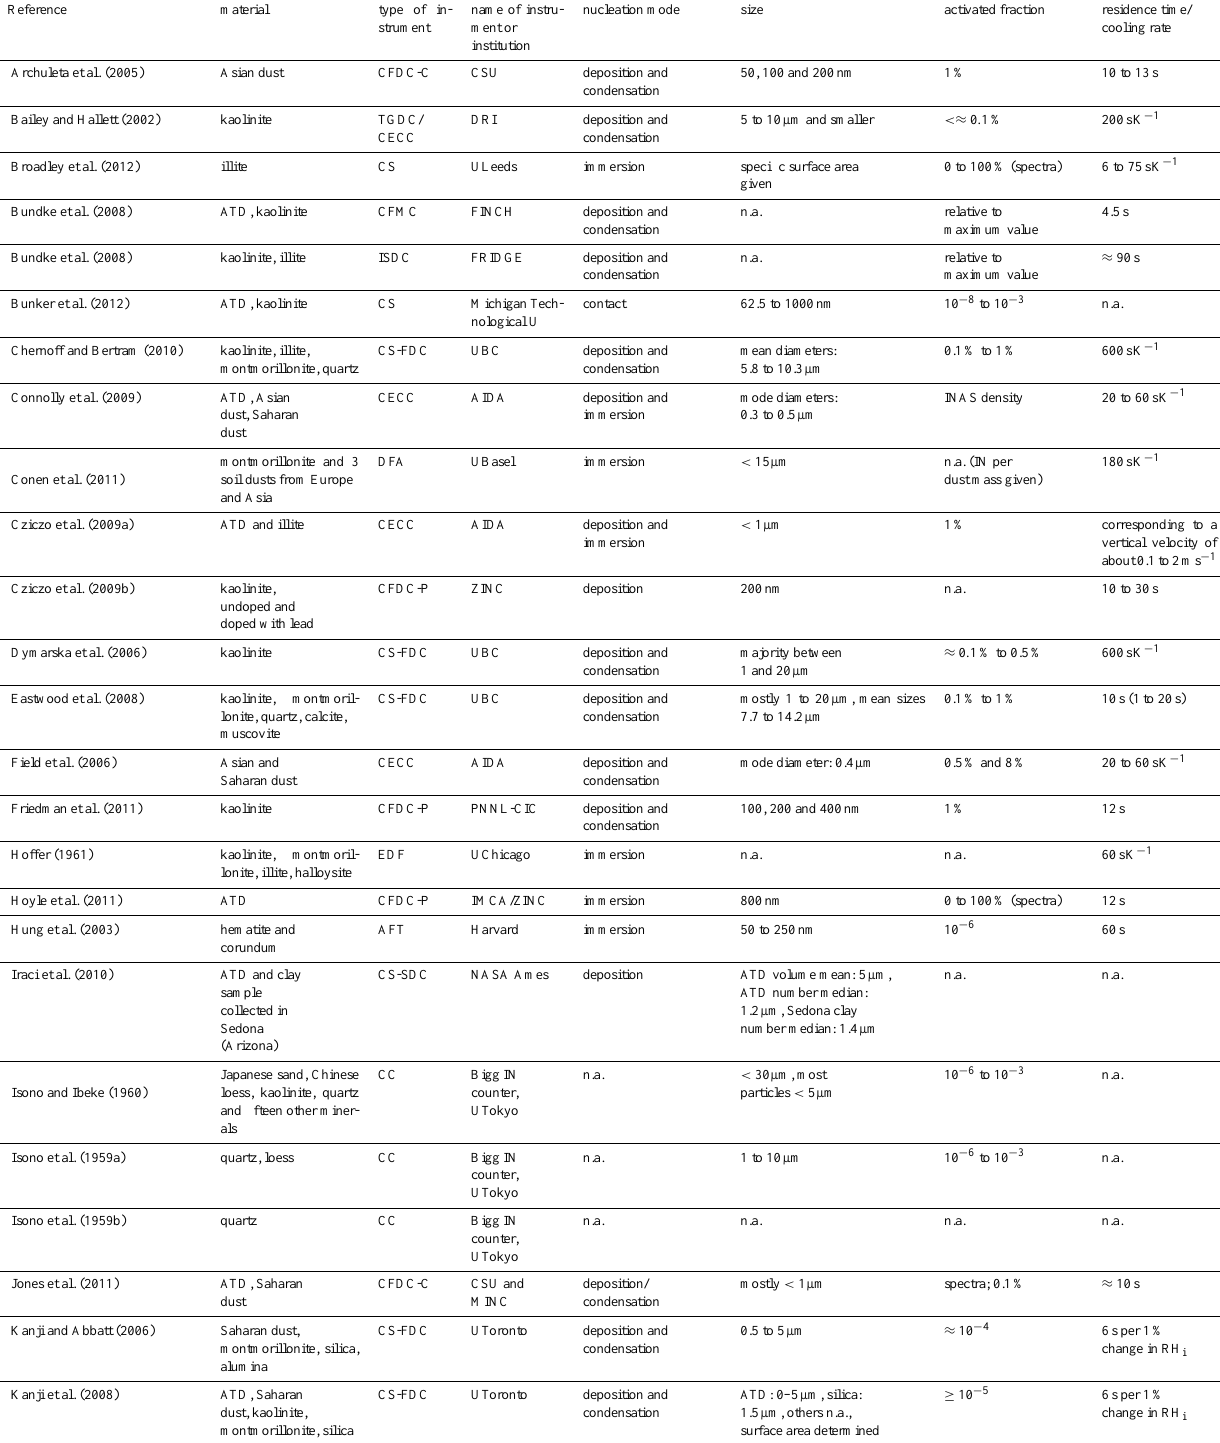
Table 1. Laboratory experiments with mineral dust